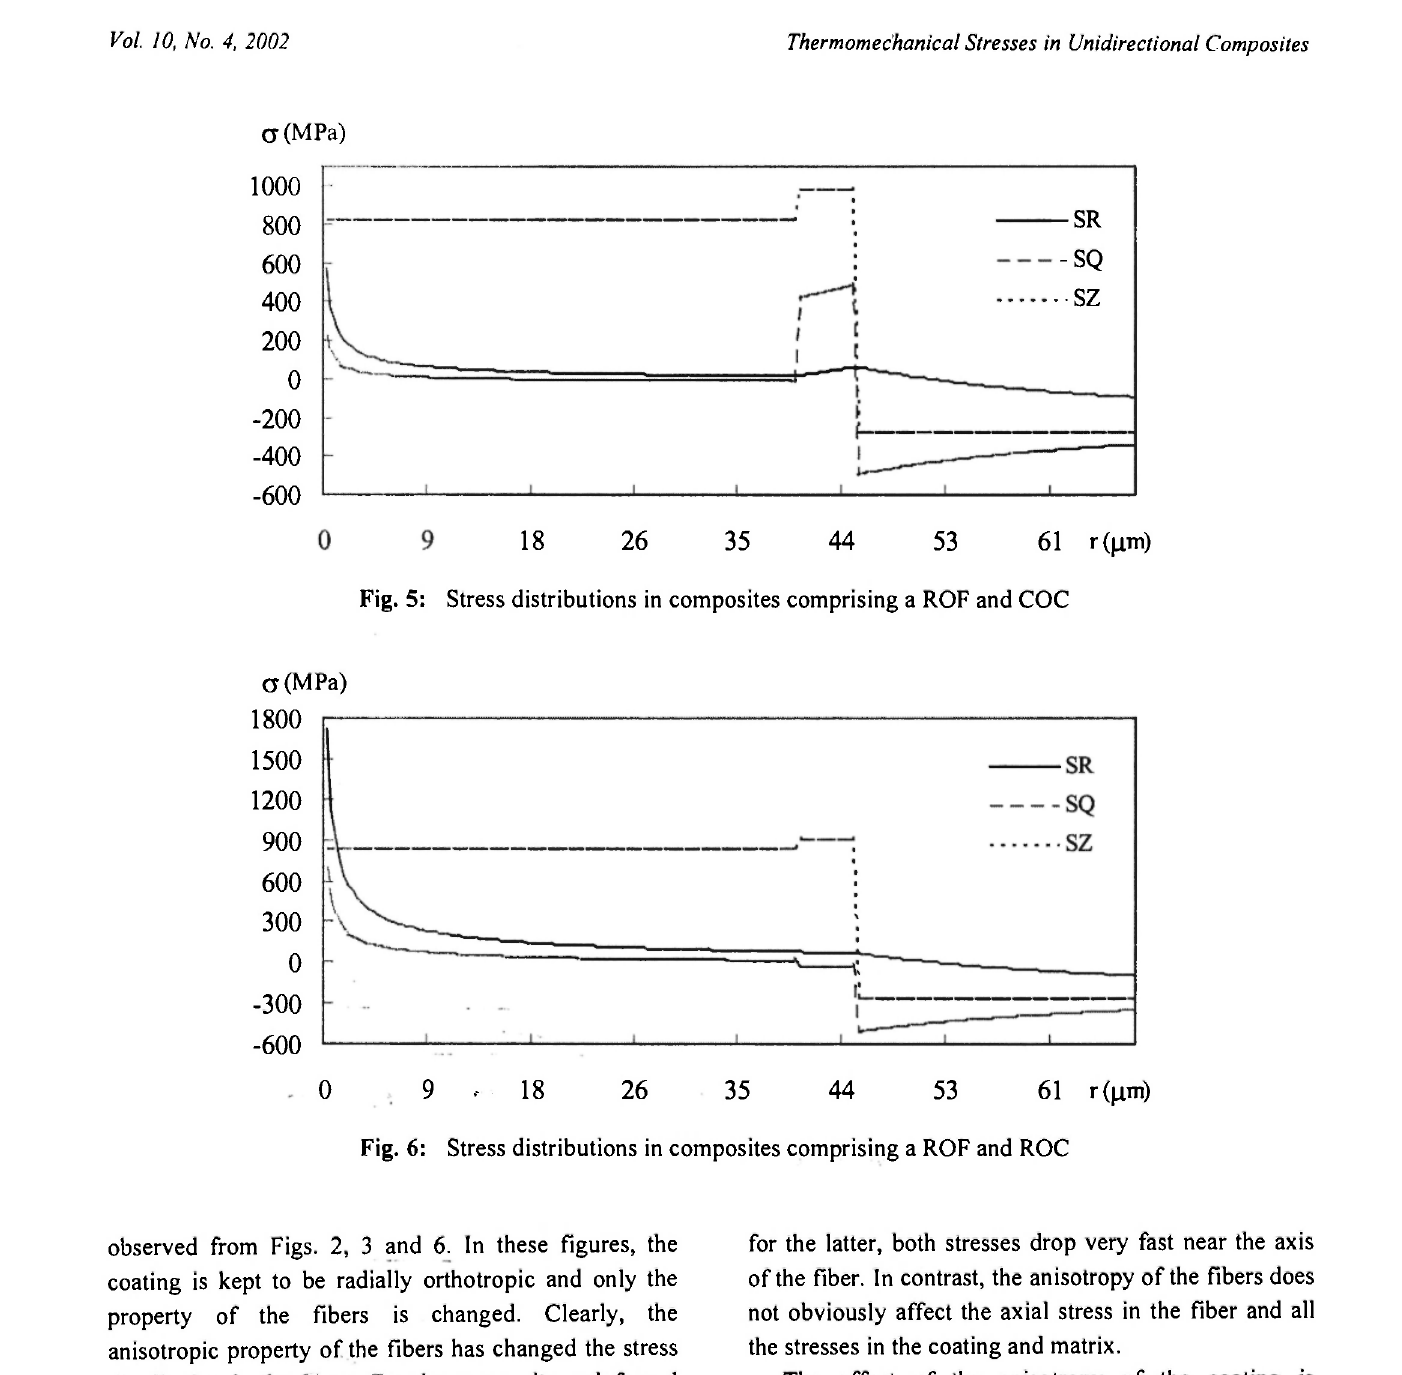
Fig. 6: Stress distributions in composites comprising a ROF and